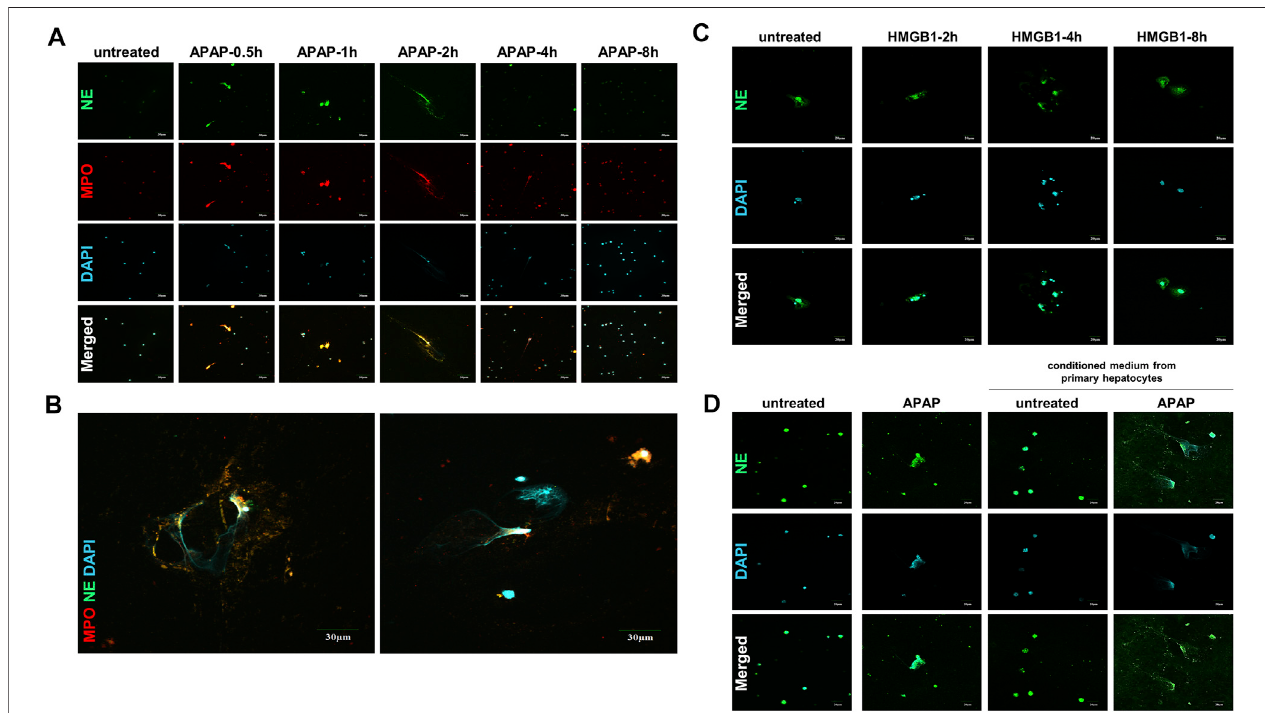
FIGURE 3 | APAP induces the formation of primary neutrophils NETs and there is a cross-talk between HMGB1 mediated neutrophils and APAP-induced primary hepatocytes. To study the effect of APAP on the formation of neutrophil NETs, APAP (5 mM) treated AML12 cells for 0 – 8 h (A,B) The parallel results of NE and MPO immuno fl uorescence staining and APAPtreatmentfor 2 h. (C) Neutrophils treatedwith 100 ng/ml HMGB1 protein for 0 – 8 h. (D) Crosstalkbetweenprimary mouse liver cells and neutrophils. After the primary mouse hepatocytes was treated with APAP (5 mM) for 24 h, the supernatant was used as a conditioned medium and cultured on neutrophils for another 2 h. The results of the immuno fl uorescence of NE in the neutrophils were obtained. The display image is the result of 600 × magni fi cations taken by Olympus confocal